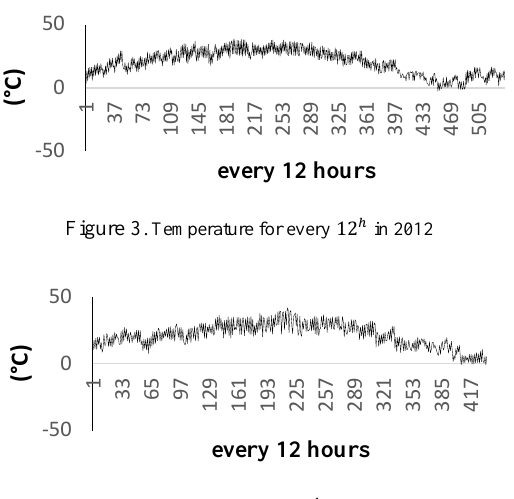
Figure 4 . Temperature for every 12 ℎ in 2013